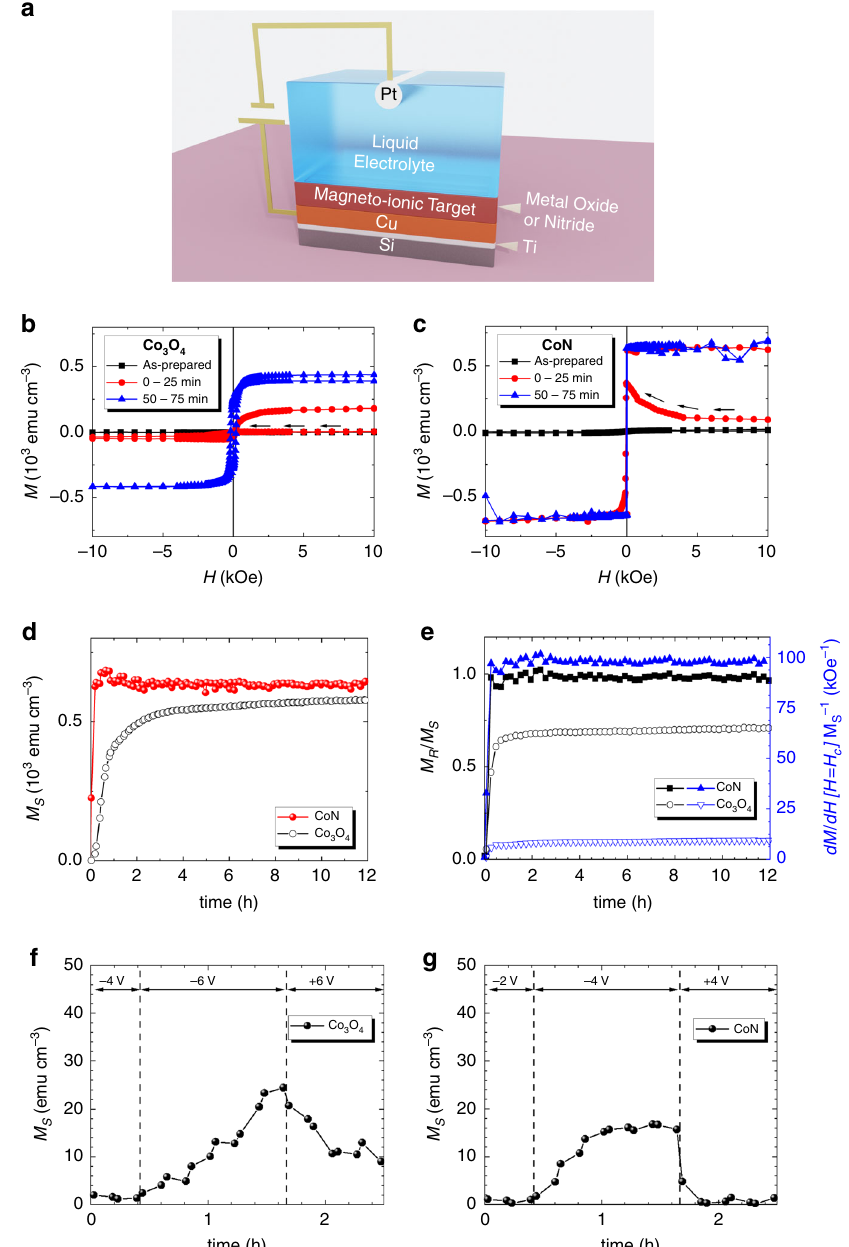
Fig. 1 Oxygen vs. nitrogen magneto-ionics: magnetoelectric characterization. a Schematic representation of the electrolyte-gating process in the Co 3 O 4 and CoN fi lms. b , c Hysteresis loops (each of 25 min of duration) of the as-prepared fi lm (black) and under – 50 V gating (the fi rst (0 – 25 min) and the third (50 – 75 min) cycles are shown only) for the Co 3 O 4 and CoN fi lms, respectively, obtained by in-plane vibrating sample magnetometry. d Time evolution of the saturation magnetization ( M S vs. t ) and e squareness ( M R / M S ) and slope of hysteresis loop at H C normalized to M S (d M /d H [ H = H C ] M S – 1 ) for each fi lm. f , g Time evolution of M – 2 V to determine the onset voltage required to display S when the gating is monotonically increased in steps of ferromagnetism for Co 3 O 4 and CoN, respectively. Table 1 Oxygen vs. nitrogen magneto-ionics by magnetoelectric measurements.